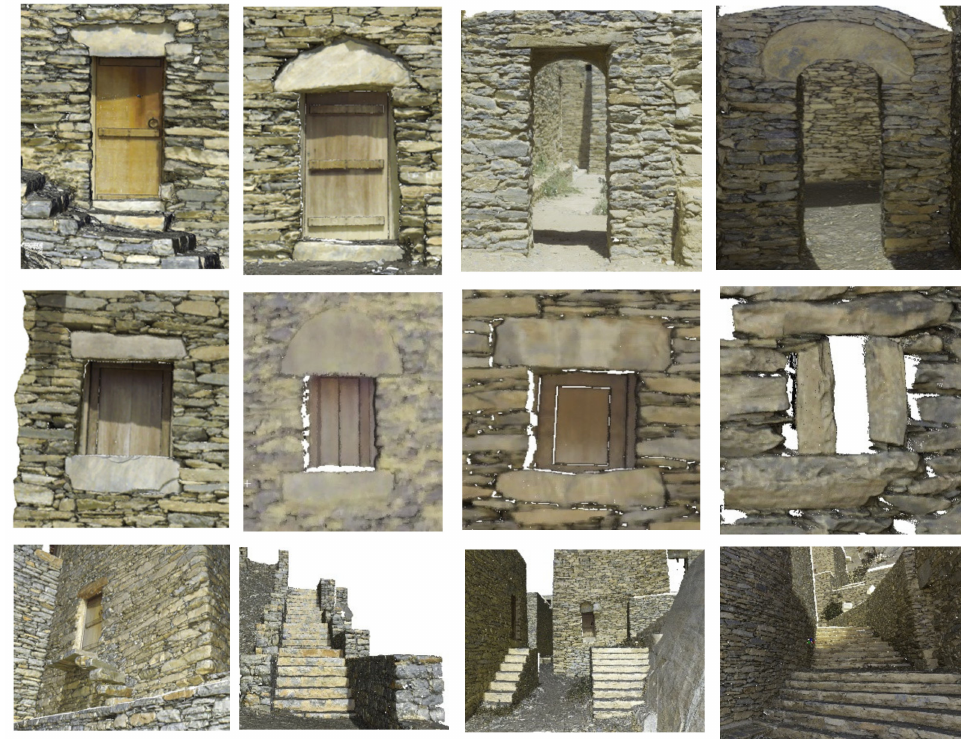
Figure 6. Common architecture elements in Zee Ain Village (colored point cloud).